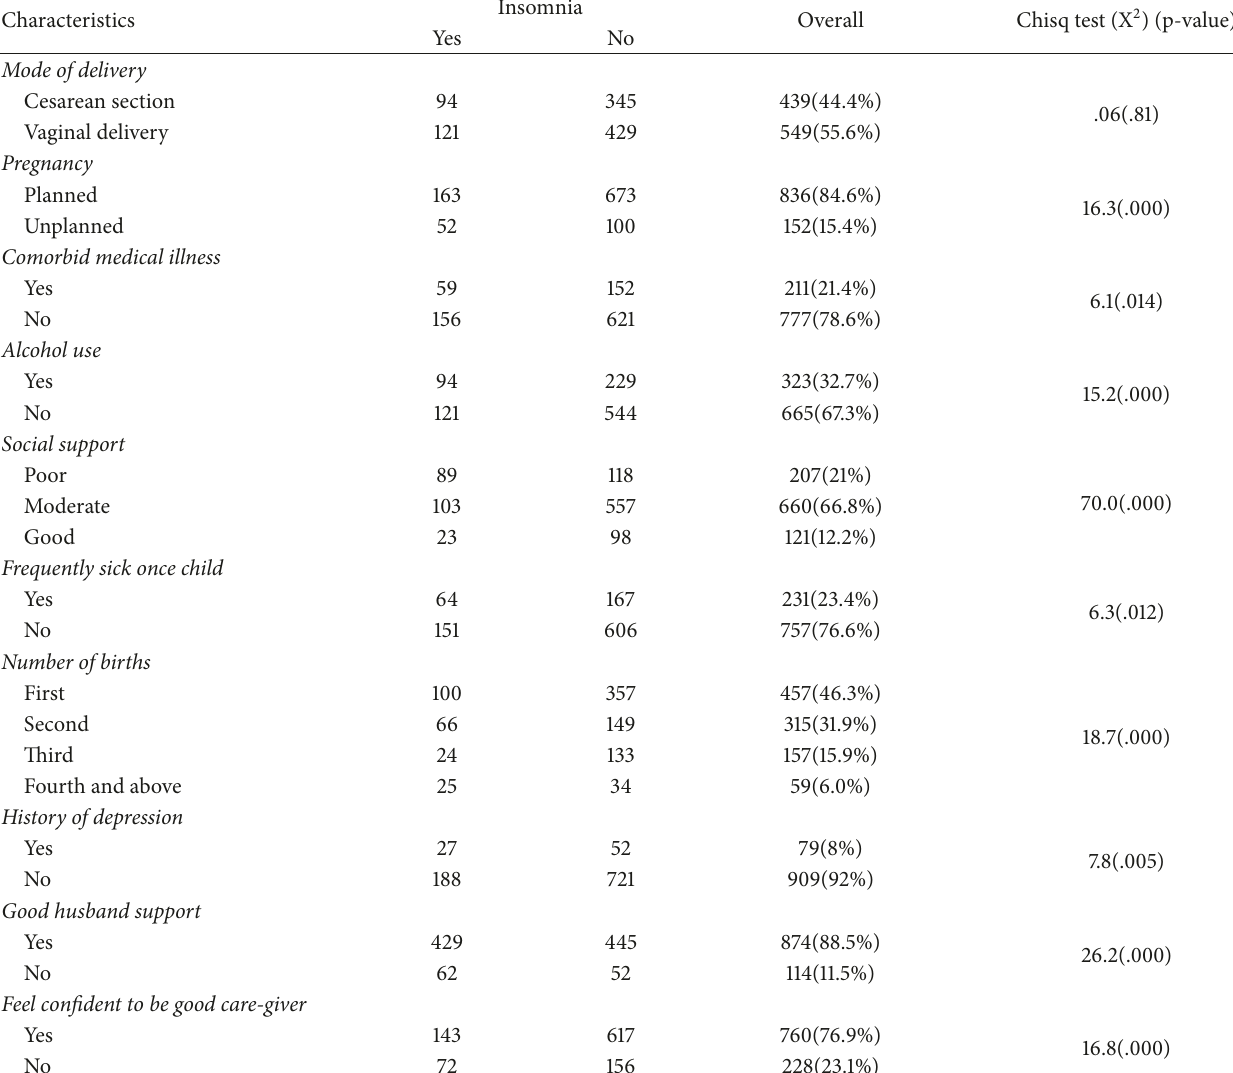
Table 2: Mothers’ clinical and psychosocial factors in relation with sleep